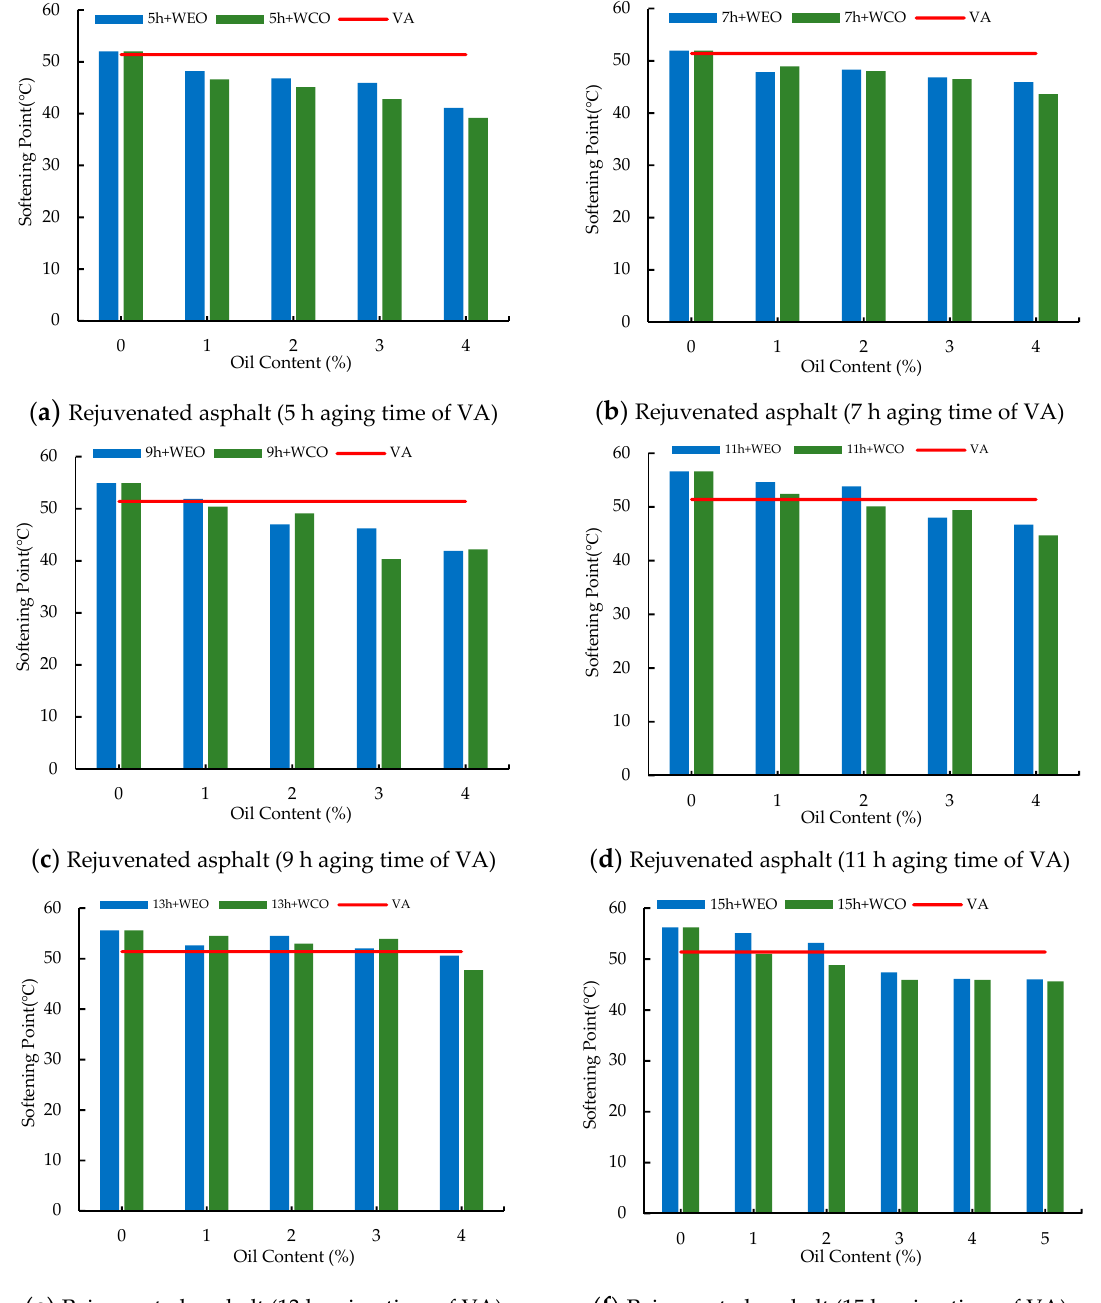
Figure 7. Effects of WEO and WCO on softening point of different aged asphalt. Figure 7. E ff ects of WEO and WCO on softening point of di ff erent aged